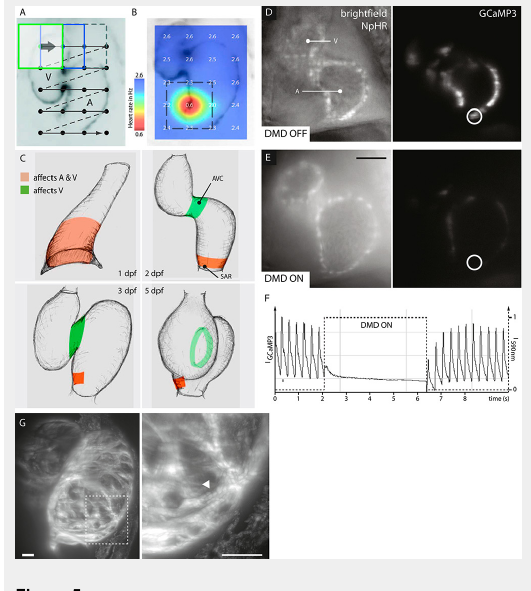
Optical manipulation in halorhodopsin-expressing zebrafish hearts. A-C: Patterned illumination reveals the location of the sinus venosus in hearts of transgenic Tg(s1101t:Gal4, UAS:NpHR- mCherry, UAS:Kaede) zebrafish. A: A sequence of rectangular 590 nm illumination is moved over the zebrafish heart located in the field of view. B: A heat map of the heart rate is generated from simultaneously recorded movies, highlighting the area with the highest impact on overall heart rate. C: Areas that control atrial and ventricular (red) or only ventricular (green) contractions are revealed throughout embryogenesis. D–F: Optical manipulation and simultaneous calcium imaging reveal myocardial calcium levels. 3 dpf transgenic Tg(myl7:Gal4, UAS:NpHR-mCherry, UAS:GCaMP3) zebrafish. D: Unperturbed heart with periodic cardiac contractions and calcium release. E: Optogenetically silenced heart without calcium release. F: Calcium transients before, during and after optical manipulation. A saturation effect is visible upon release of illumination. Scale bar: 50 µm. G: High-resolution 3D imaging of sarcomere structures (arrow head) in an optically relaxed heart. Transgenic Tg(myl7:LifeAct-GFP, myl7:Gal4, UAS:NpHR-mCherry) zebrafish. 5 s illumination with 590 nm and simultaneous image